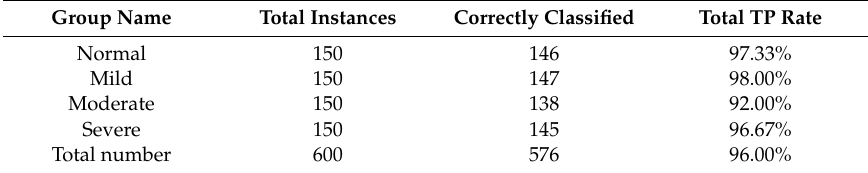
Table 5. Group classification results.